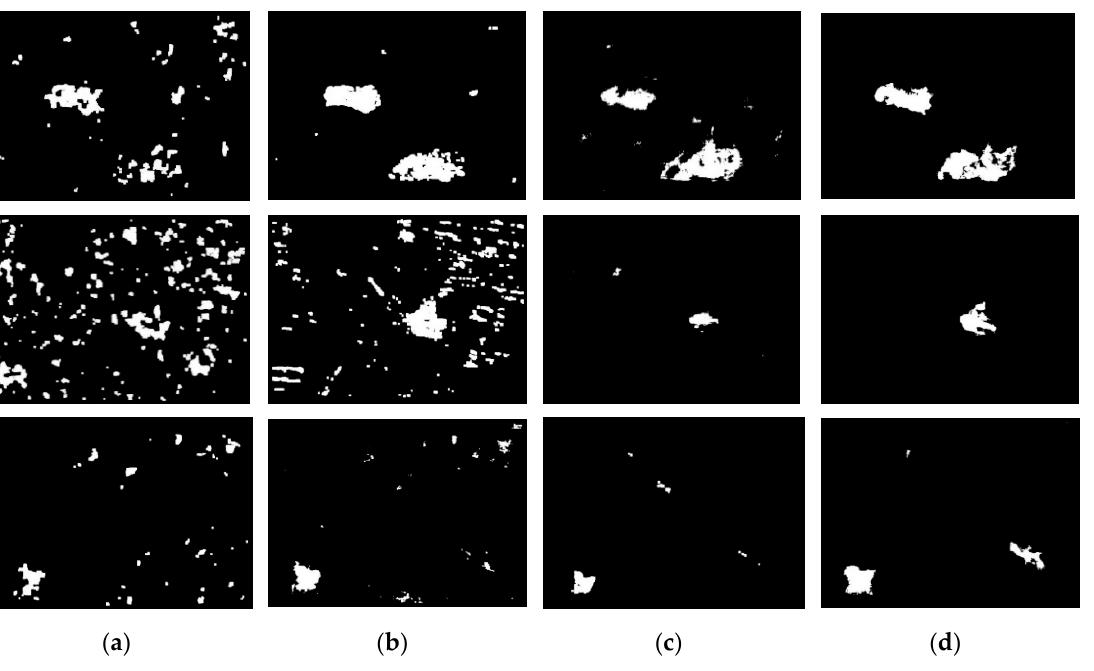
Figure 9. Detection results for three areas when using the existing and proposed algorithms: ( a ) DI + CNN, ( b ) JF + CNN, ( c ) dual-DCN, and ( d ) the proposed fusion network.